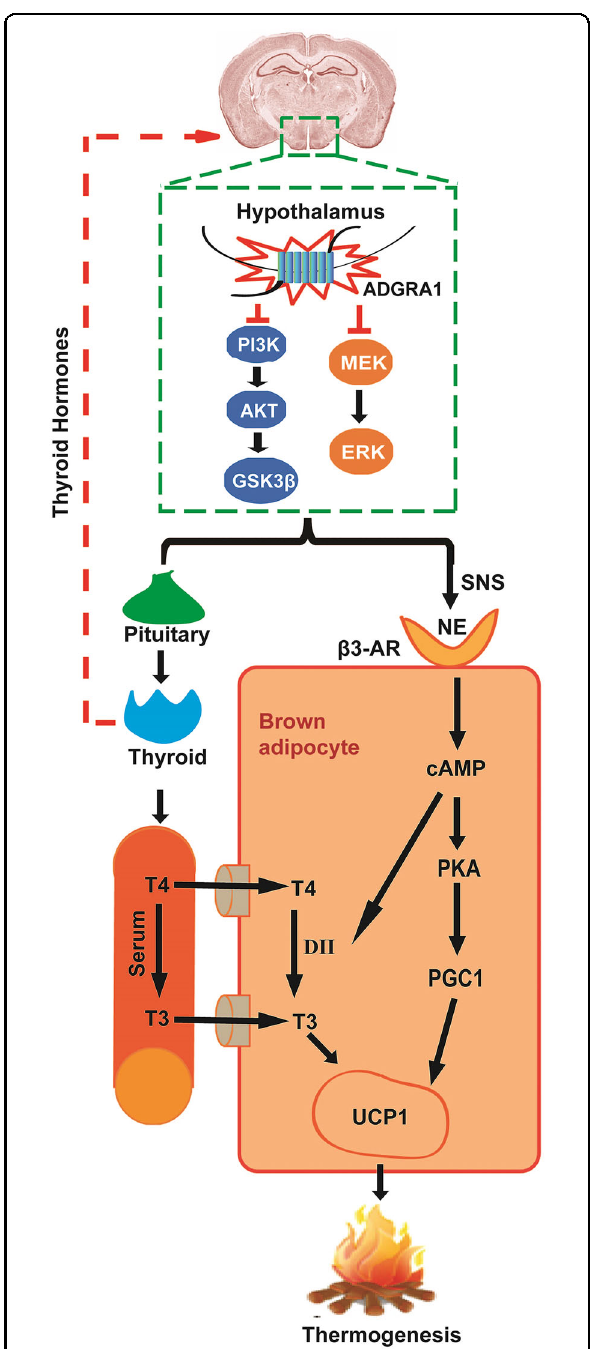
Fig. 8 Schematic overview summarizing the physiological effects of ADGRA1 on energy balance in male mice. ADGRA1 in male mice modulates the PI3K/AKT/GSK3 β and MEK/ERK pathways in the hypothalamus, negatively regulating both hypothalamus – pituitary – thyroid axis and SNS. NE is released from SNS and interacts with β 3-AR in brown adipocytes. On one hand, the interaction initiates a cascade of reaction activating the PGC1 and resulting in the expression of UCP1. On the other hand, the interaction can also activate the DII, which promotes the conversion of T4 to T3, as a result, the UCP1 is expressed. Together, heat is